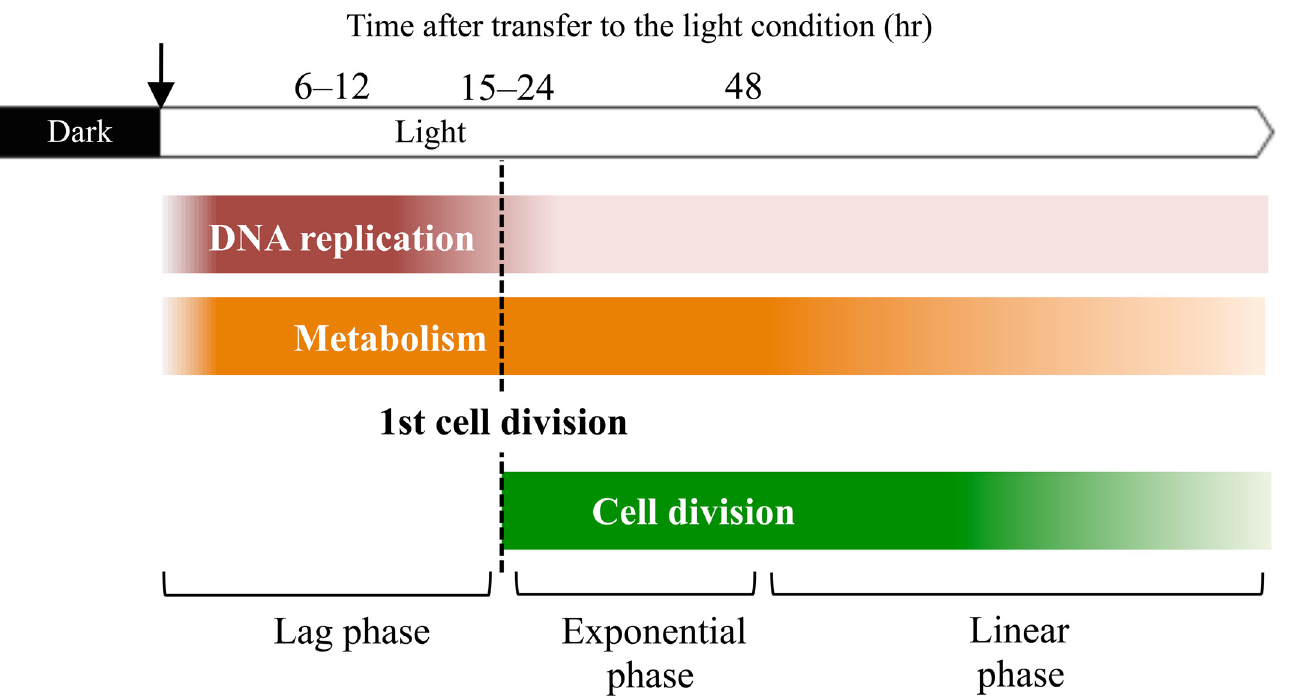
Fig 6. Schematic drawing depicting the growth phases of Synechococcus